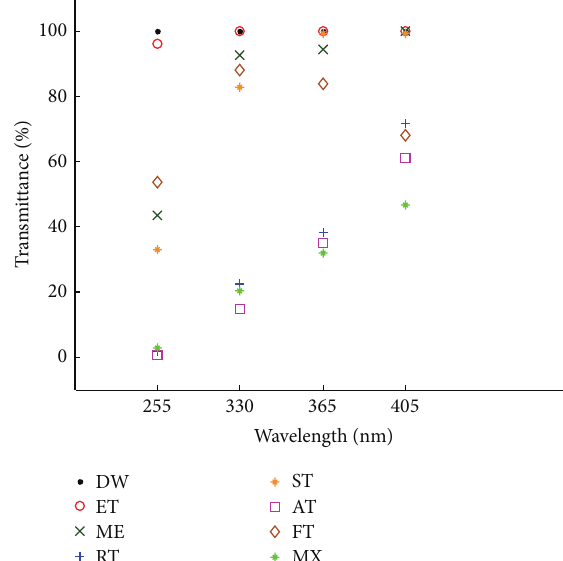
Figure 2: Transmittance of distilled water (DW), ethanol (ET), methanol (ME), aged tequila (AT), rested tequila (RT), mixed tequila (MX), silver tequila (ST), and a fake tequila (FT) at 255 nm, 330 nm, 365 nm, and 405